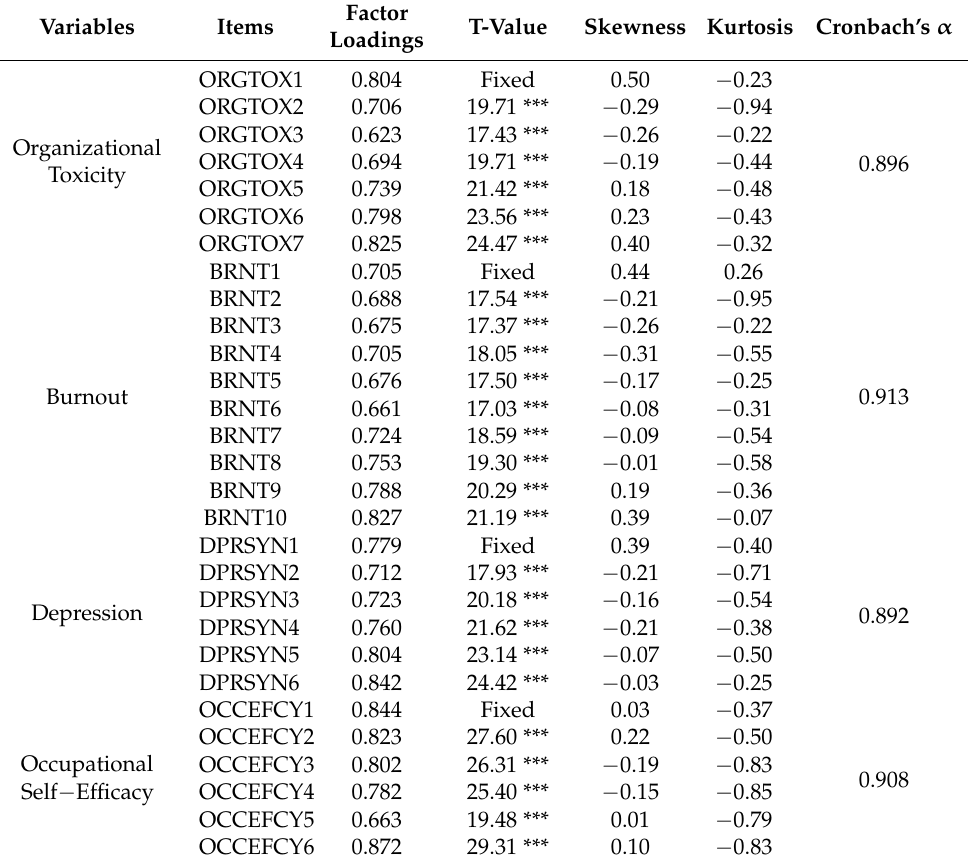
Table 2. Result of the measurement